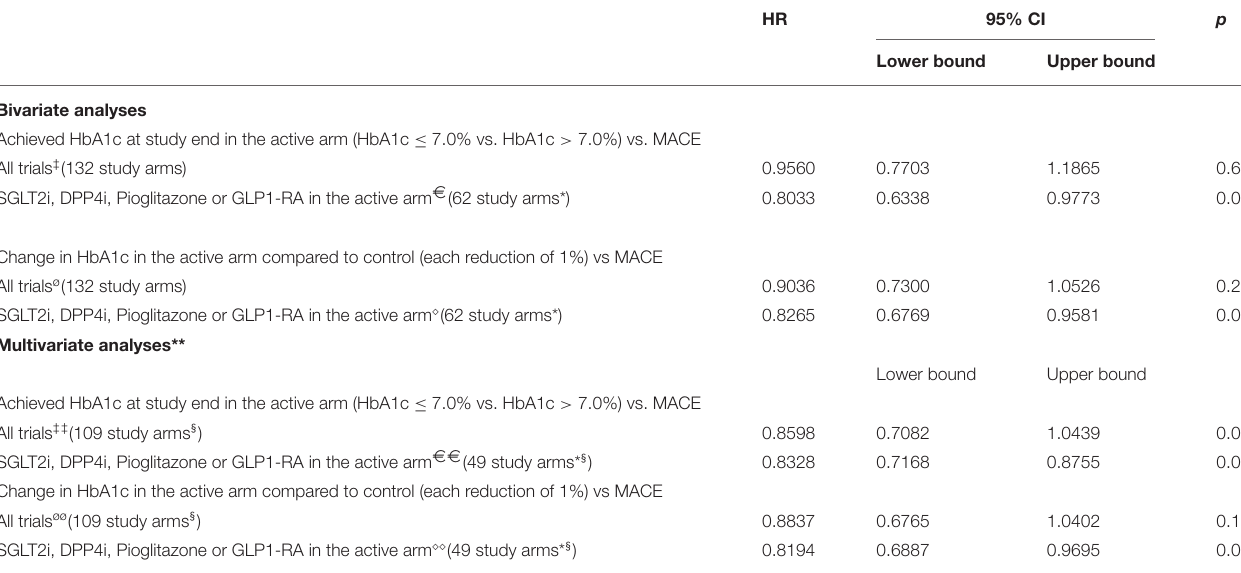
HR 95% CI p Lower bound Upper bound